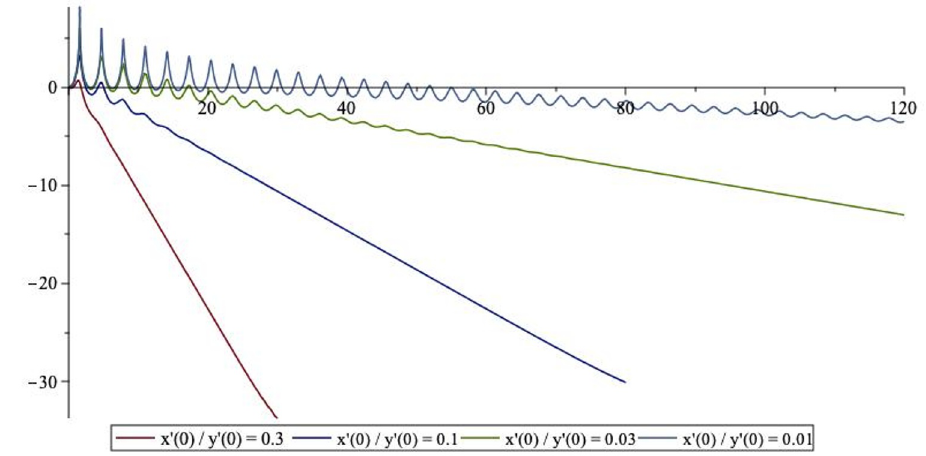
(cid:0) ( (cid:1) versus affine parameter x ( s ) − 1) 2 + y ( s ) 2 s = κ = 1 0